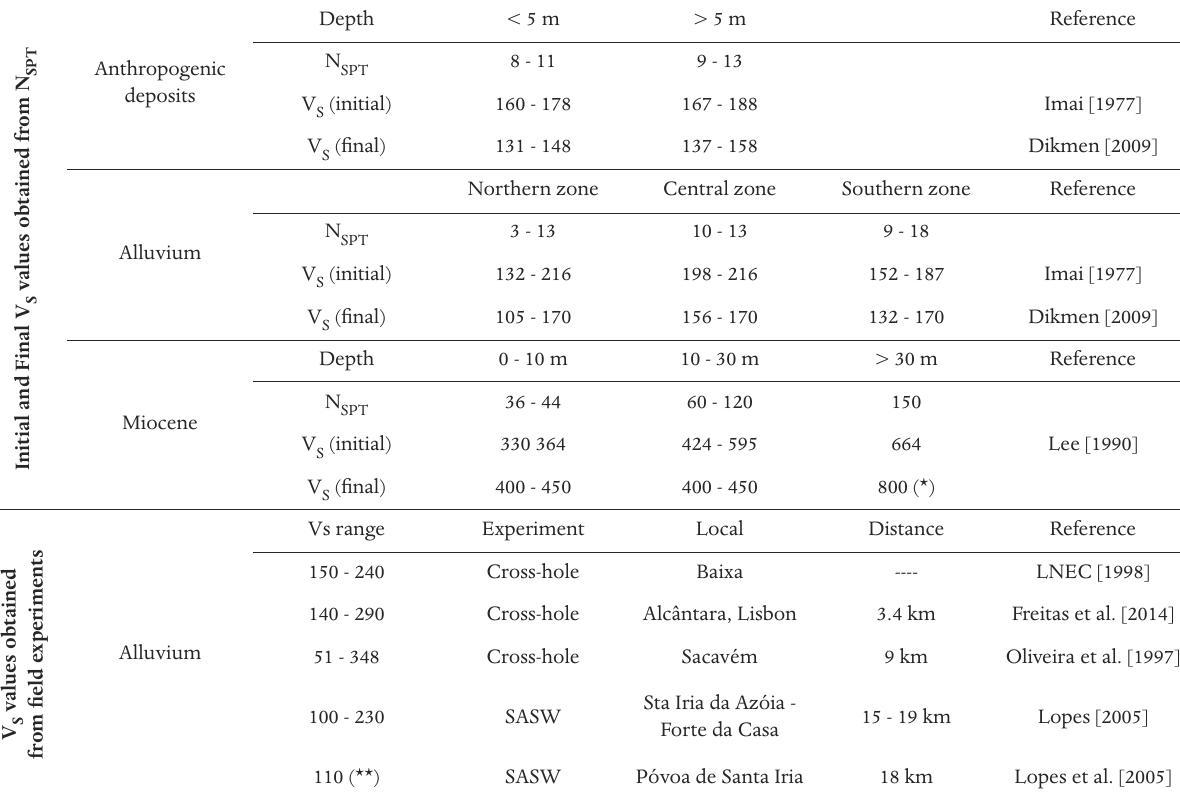
values obtained from N relationships (three first rows) and V Table 6. Initial and final V S SPT values are in m/s. (*) At depths greater than 30 m, the Miocene formations were considered as bedrock. (**) Single experiment row). All V S performed for a 7 m thick alluvium